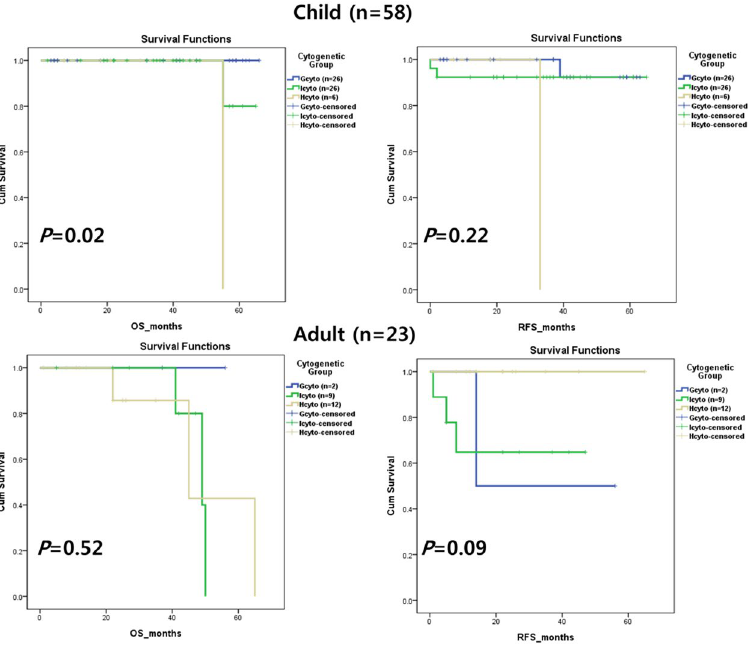
Figure 3. Clinical outcomes by cytogenetic group. Overall survival (OS) and relapse-free survival (RFS) were both found to be statistically significant ( P < 0.5) in child B-cell lymphoblastic leukemia/lymphoma (B-ALL). RFS was statistically significant in adult B-ALL. Child B-ALL were classified into good cytogenetic (Gcyto, n = 26), intermediate cytogenetic (Icyto, n = 26), and high cytogenetic risk (Hcyto, n = 6) groups. Adult B-ALL were classified into Gcyto (n = 2), Icyto (n = 9), and Hcyto (n = 12) groups.